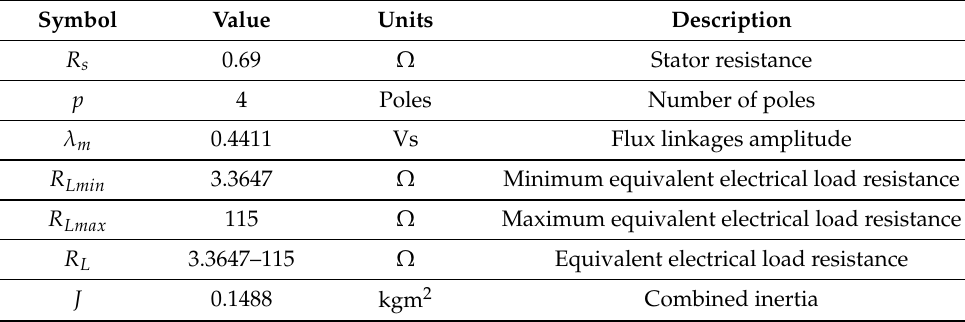
Figure 4. Experimental setup for speed variator-induction motor-PMSG. Table 2. Parameters associated to the